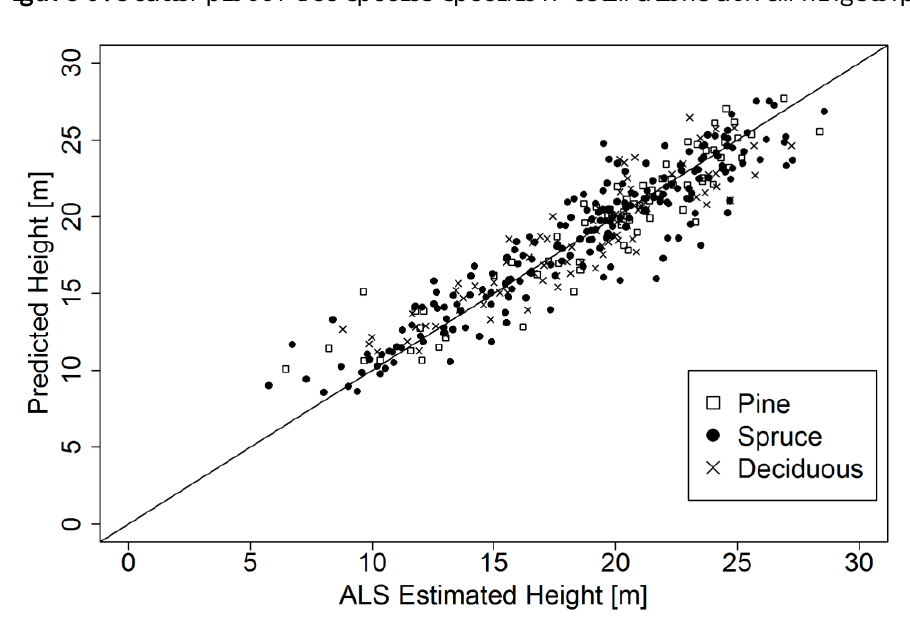
Figure 6. Scatter plot of tree species-specific H estimations at